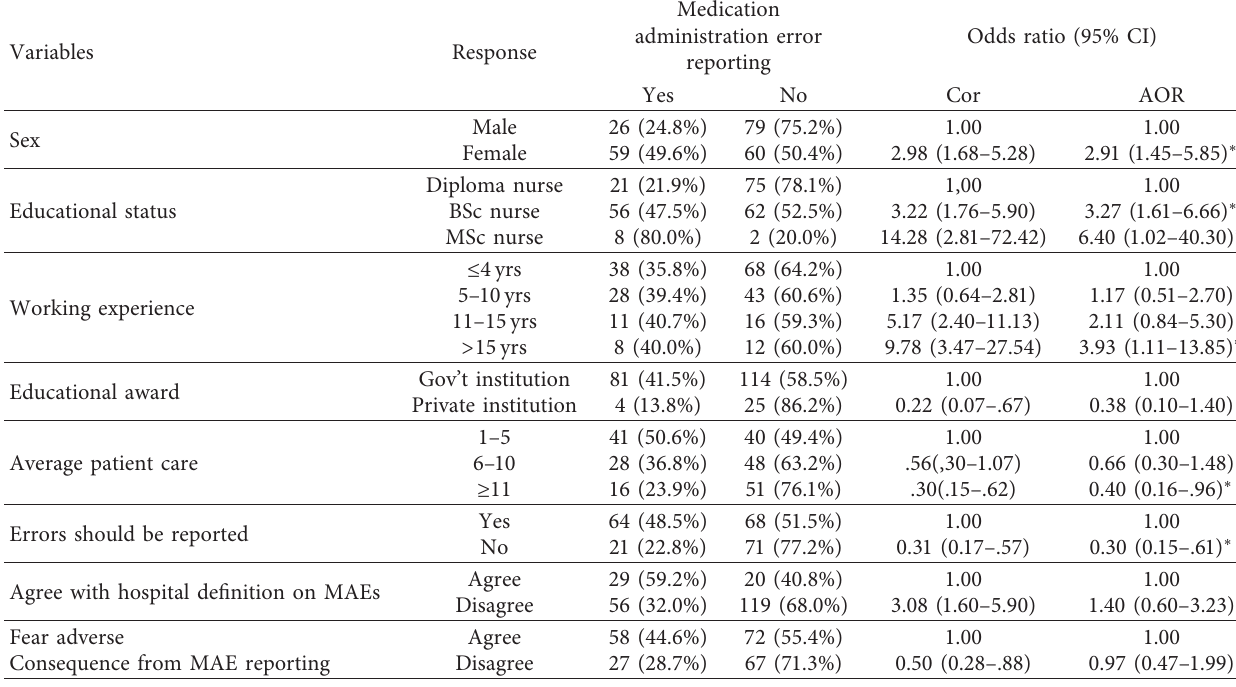
Table 5: Bivariate and multivariable logistic regression analysis of factors associated with 278 nurses MAE reporting working in public hospitals of North Shoa zone, Amhara, Ethiopia, 2019.